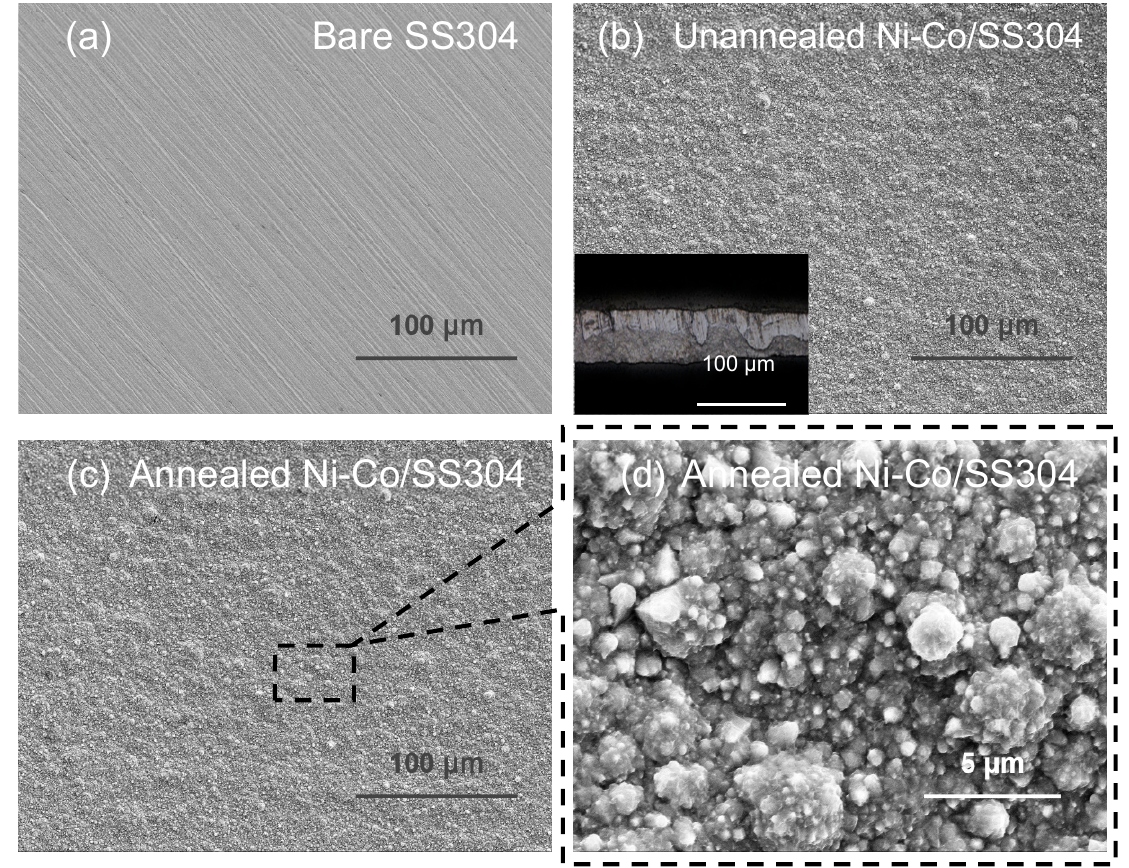
Figure 2. SEM surface morphology of different surfaces: ( a ) bare SS304; ( b ) unannealed Ni–Co/SS304, and the illustration in ( b ) is the cross-section of Ni–Co coating photographed by a 3D measuring laser microscope; ( c , d ) annealed Ni–Co/SS304.